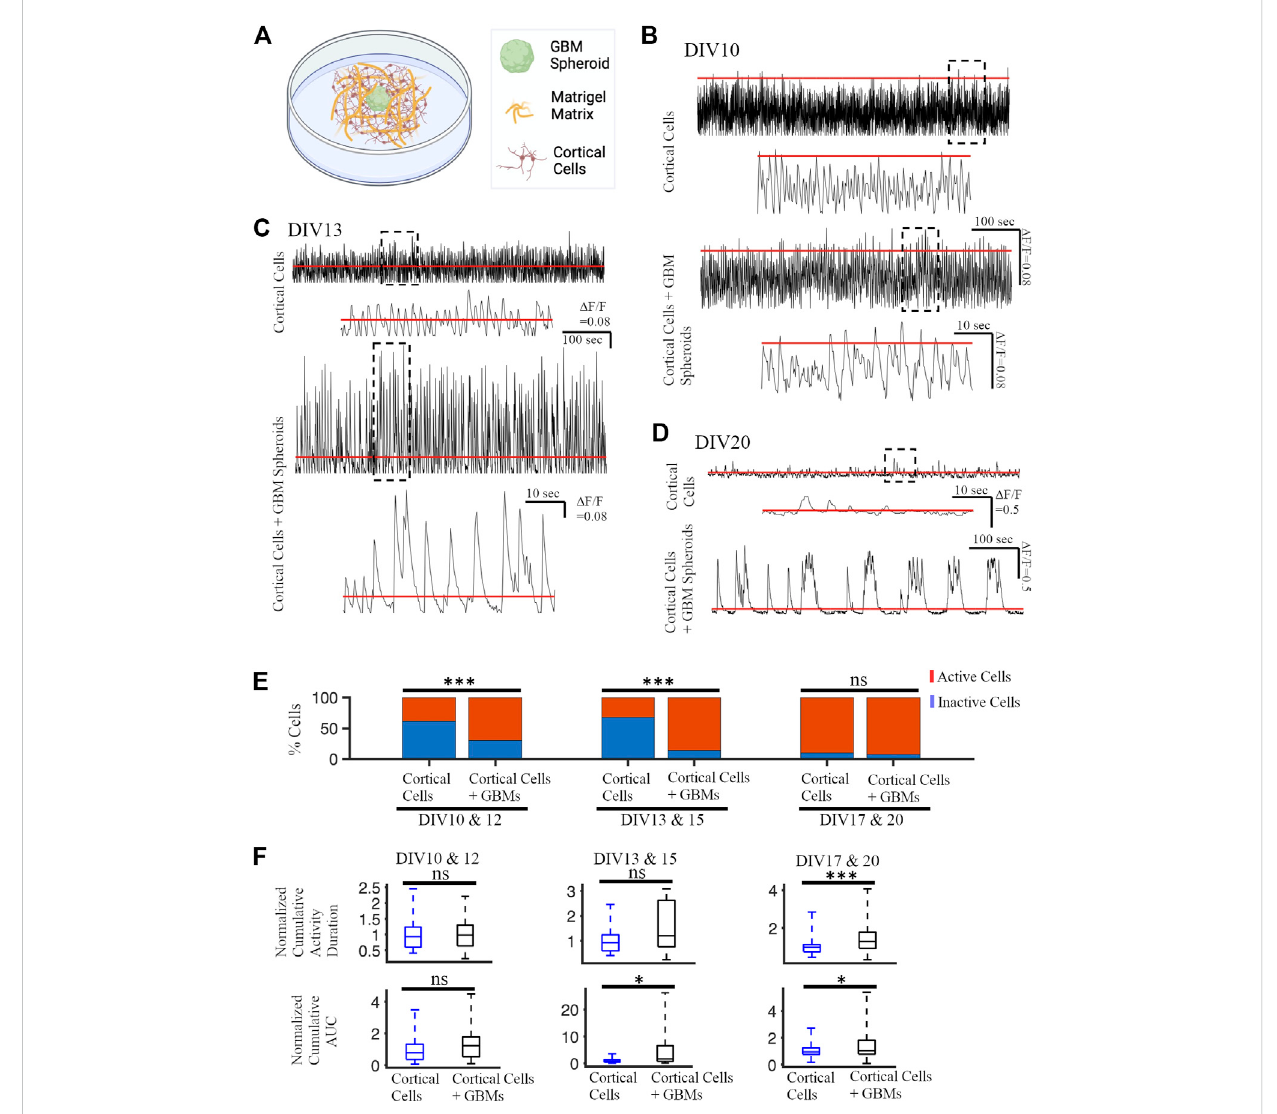
FIGURE 8 Neuronalactivityinmatrixco-cultures. (A) SchematicofaGBMspheroidwithcorticalcellsinMatrigel. (B) Representativecalciumtracesofacortical neuronculturedinMatrigelwithandwithoutGBMspheroidsonDIV10.Theinsetshowstheportionofthetracecontainedinadashedblackboxinhigher detail. The red lines in all panels represent the threshold for activity analysis. (C) Representative calcium traces on DIV 13. (D) Representative calcium tracesDIV20. (E) ProportionsofactiveandinactiveneuronsondifferentDIVs.N=80corticalneuronsineachgrouponDIV10&12andDIV17&20. N = 50 cortical cells in each group on DIV 13 & 15. The Z-score test was used to measure the statistical signi fi cance test. *** p < 0.001. (F) Normalized cumulative activity duration and normalized cumulative area under the curve (AUC) on different DIV. KS test was used to measure statistical signi fi cance. * p < 0.05, *** p < 10 – 4 , and ns: not signi fi